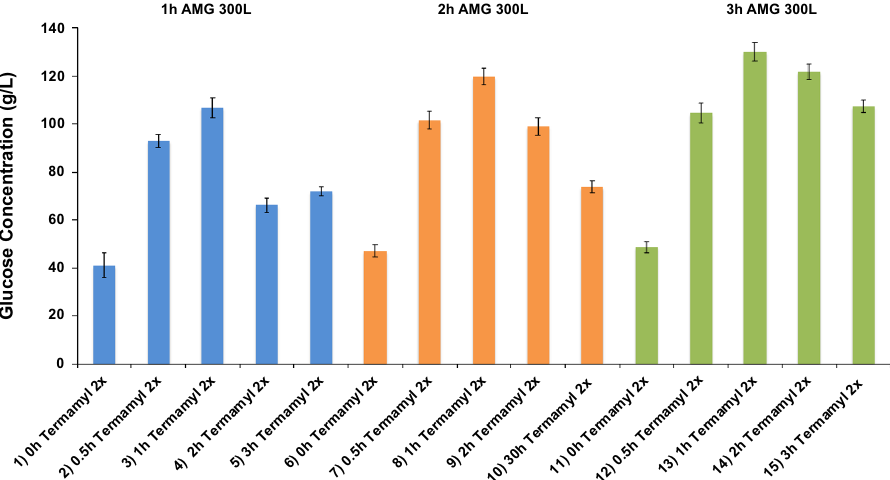
Figure 1. Glucose concentrations during enzymatic hydrolysis reactions with the enzymes Termamyl 2X and AMG 300L. The error bar represents the standard deviation from the essays carried out in